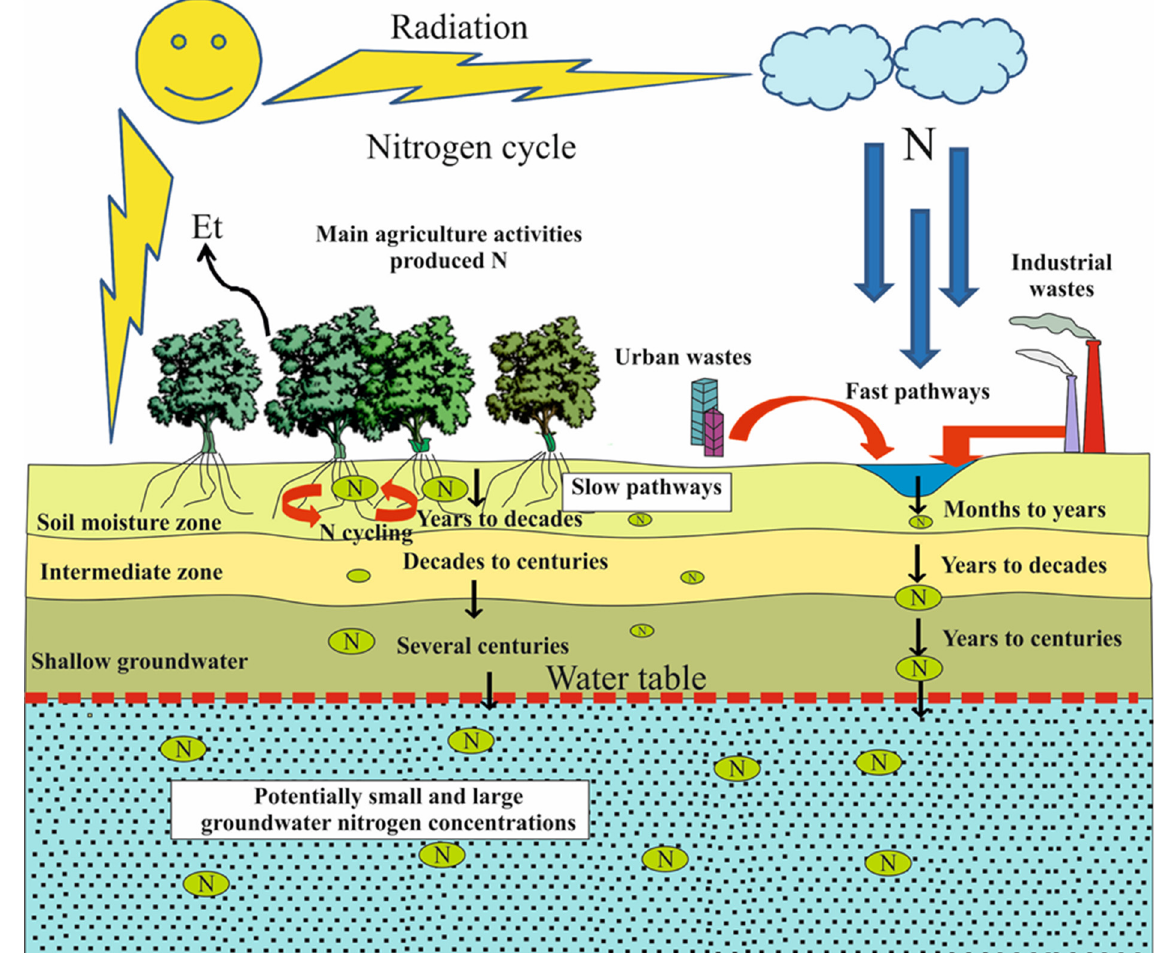
Figure 5. Demonstration of a conceptual model for nitrogen fertilizer that contaminates surface water and groundwater based on various pathways and durations of contamination.